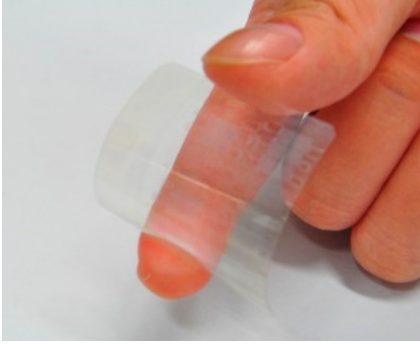
Figure 8. A transparent flexible CMUT.